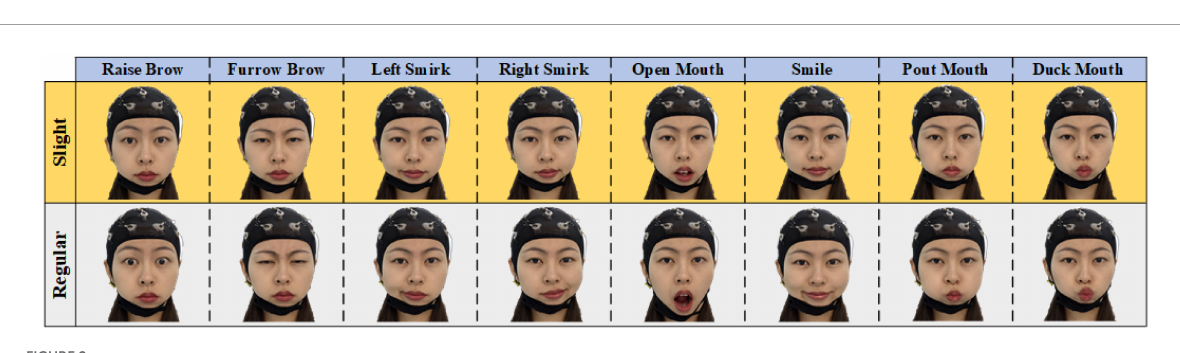
FIGURE2 Eight slight-facial expressions (sFEs) adopted in this research and their comparison with the regular